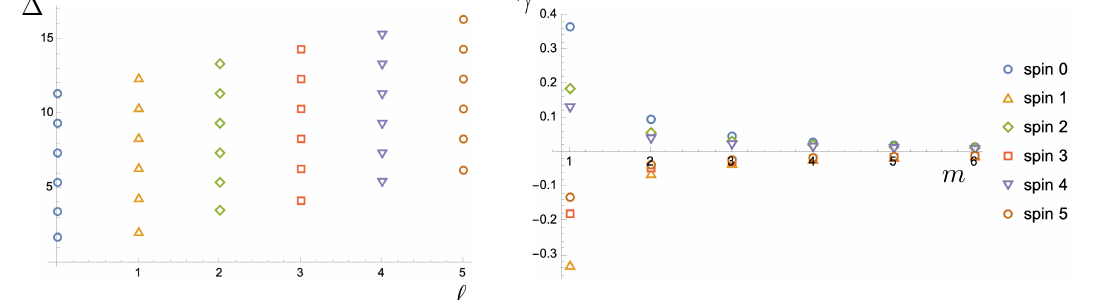
Figure 3 . Plots of the spectrum of low lying operators with ‘ ≤ 5 . On the left we plot the dimensions for various spins, while on the right we plot the anomalous dimension as a function of level number m , viz., γ ( m, ‘ ) = ∆ − 2∆ 2 m − ‘ defined in φ −